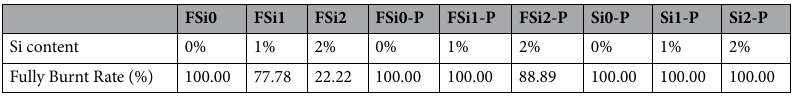
Table 5. Fully Burnt Rate in the upward flame spread test.